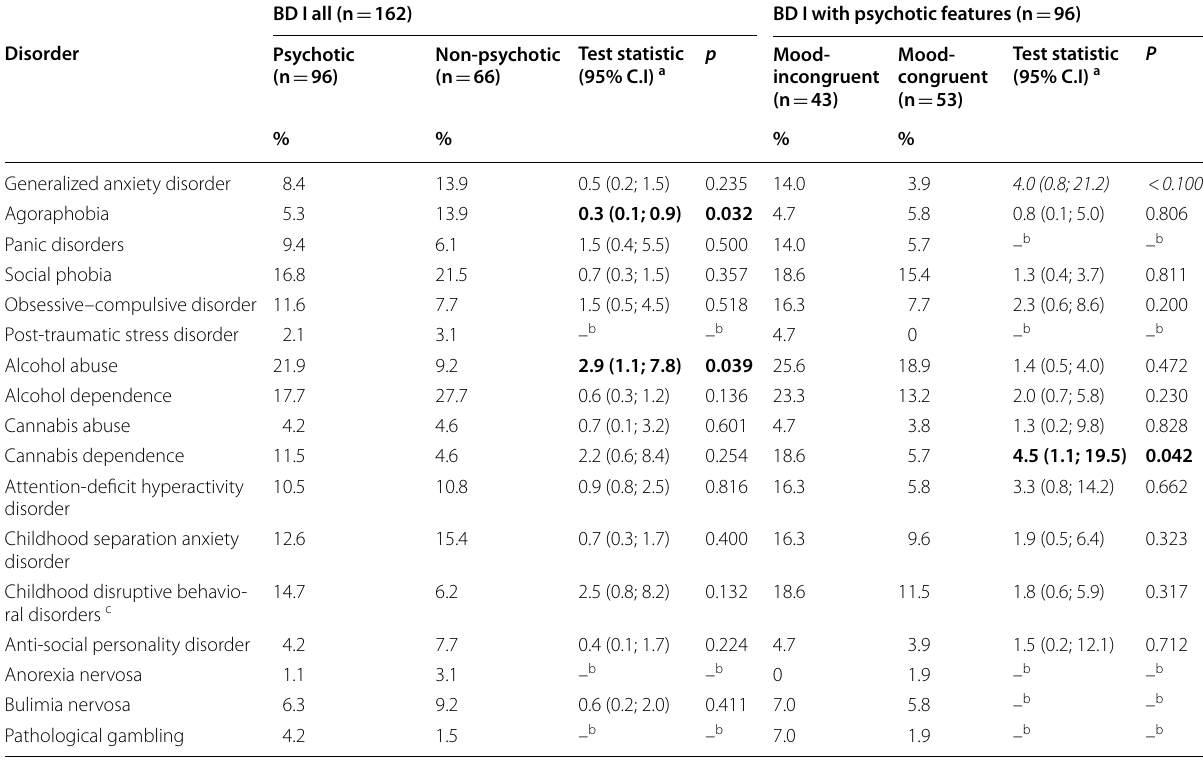
Table 3 Lifetime psychiatric comorbidity by lifetime psychotic feature